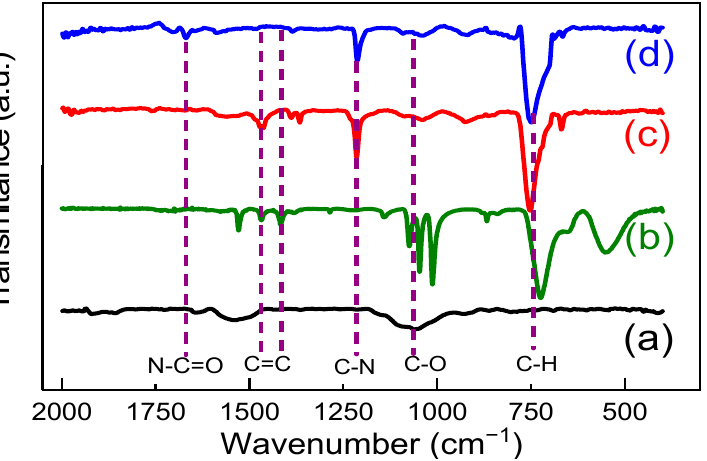
Figure 6. FTIR Spectrum of: ( a ) MWCNT, ( b ) pyrrole, ( c ) PPy/MWCNT, and ( d ) OPPy/MWCNT.